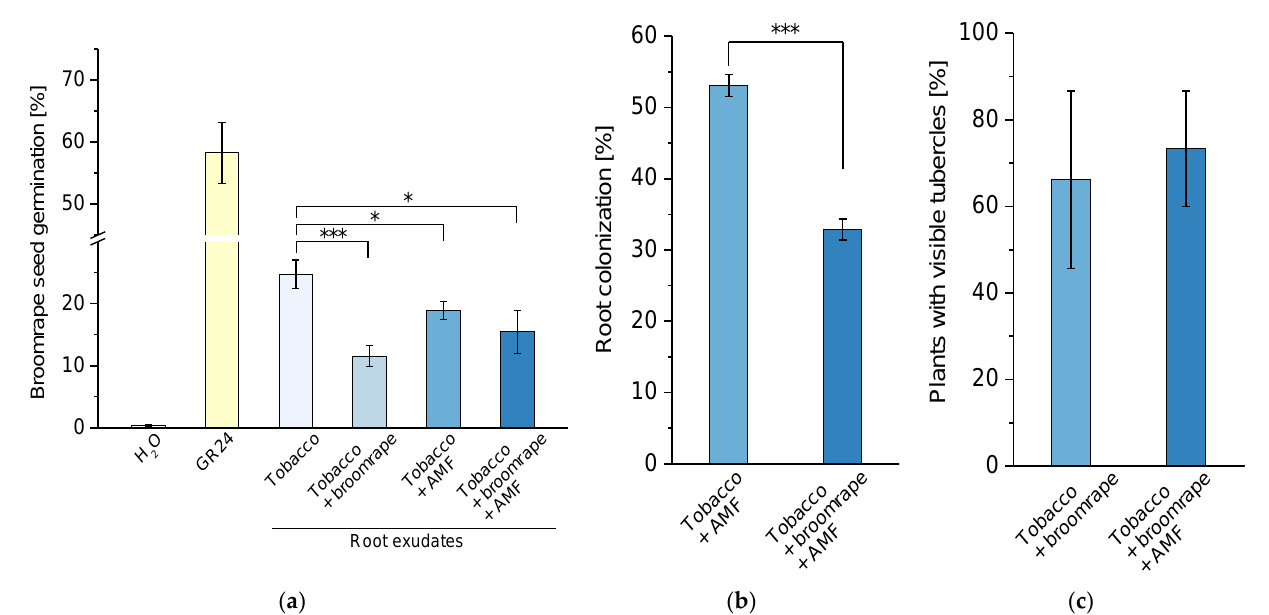
Figure 6. Antagonistic interactions within the system of host plants, parasitic plants, and AM fungi. ( a ) Germination stimulation activity of exudates from infested and/or inoculated tobacco plants on broomrape seeds in in vitro conditions. Treatments with water and the synthetic strigolactone GR24 (1.67 µM) were used as negative and positive controls, respectively. ( b ) Extent of mycorrhization of infested vs. non-infested tobacco roots. ( c ) Extent of broomrape infestation of mycorrhizal vs. non-mycorrhizal tobacco roots expressed as percentage of plants with at least one visible tubercle. Values are means of five biological repeats, i.e., independent plant cultivations and exudate collections. Error bars indicate standard error of the mean (SE). *** p < 0.001 and * p < 0.05 (Student’s t -test).